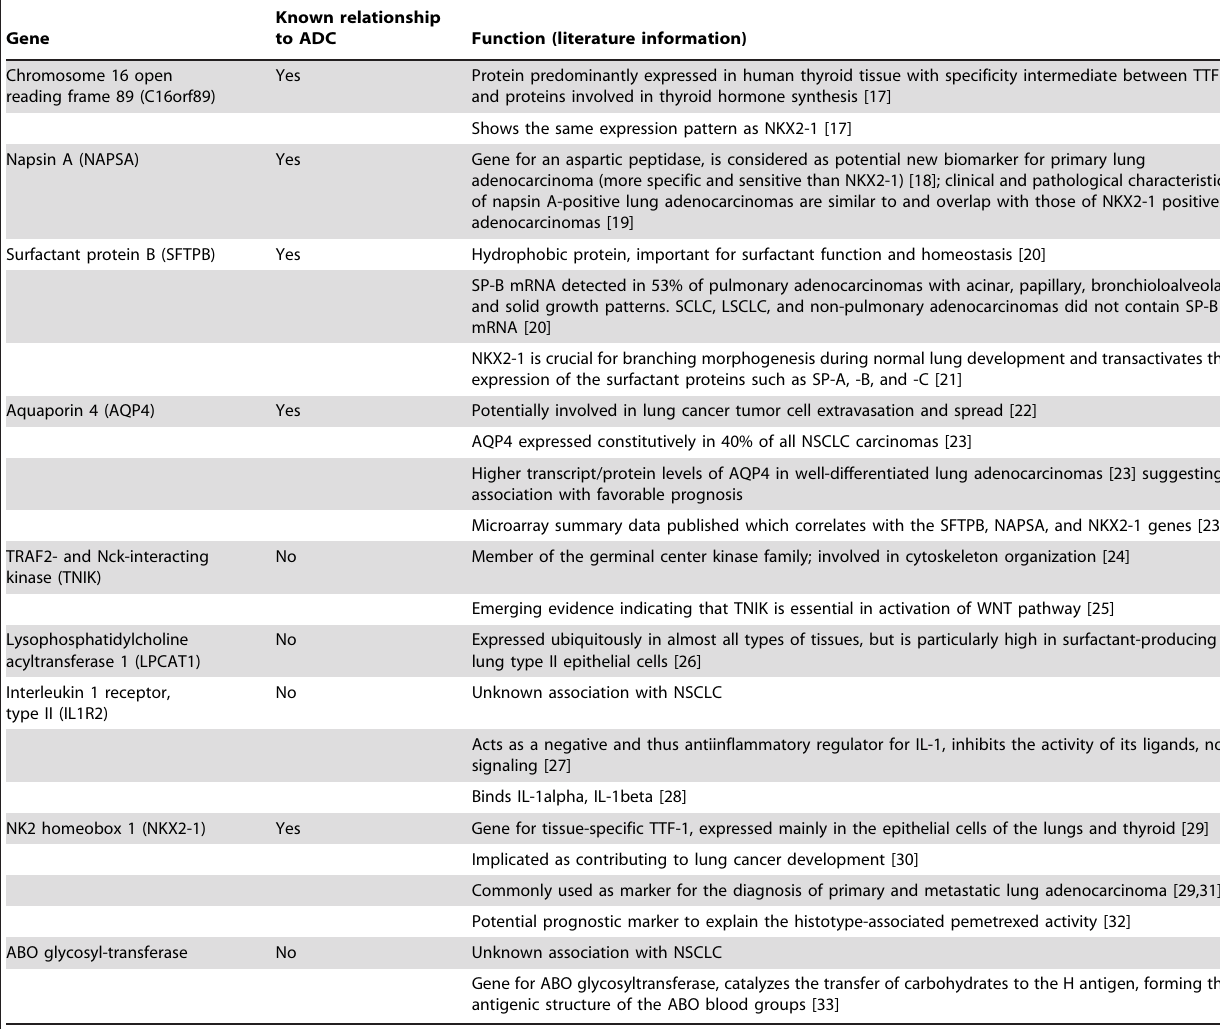
Table 3. Overview of the 9 genes showing consistent association with both PFS and OS (n=51 patients with nsNSCLC).